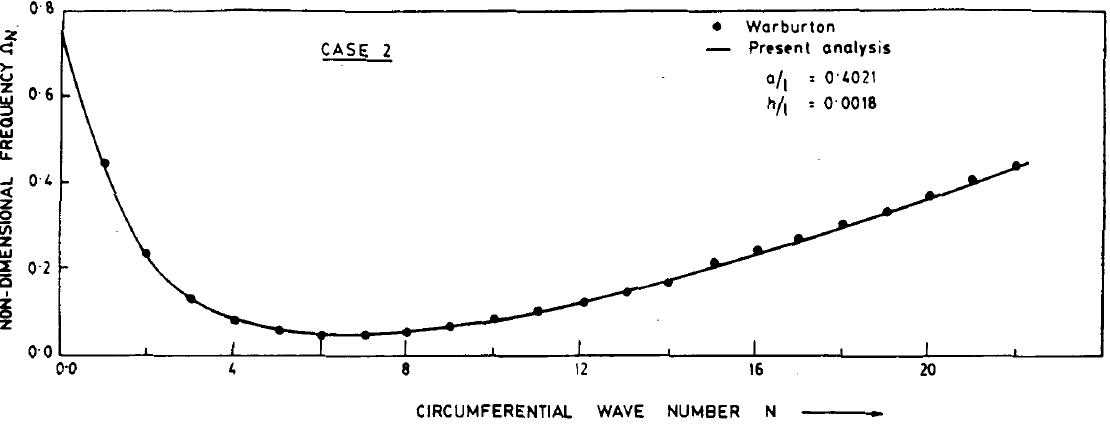
Fig. 8. Comparison of natural frequencies obtained by present analysis with those obtained from Warburton’s method (Case